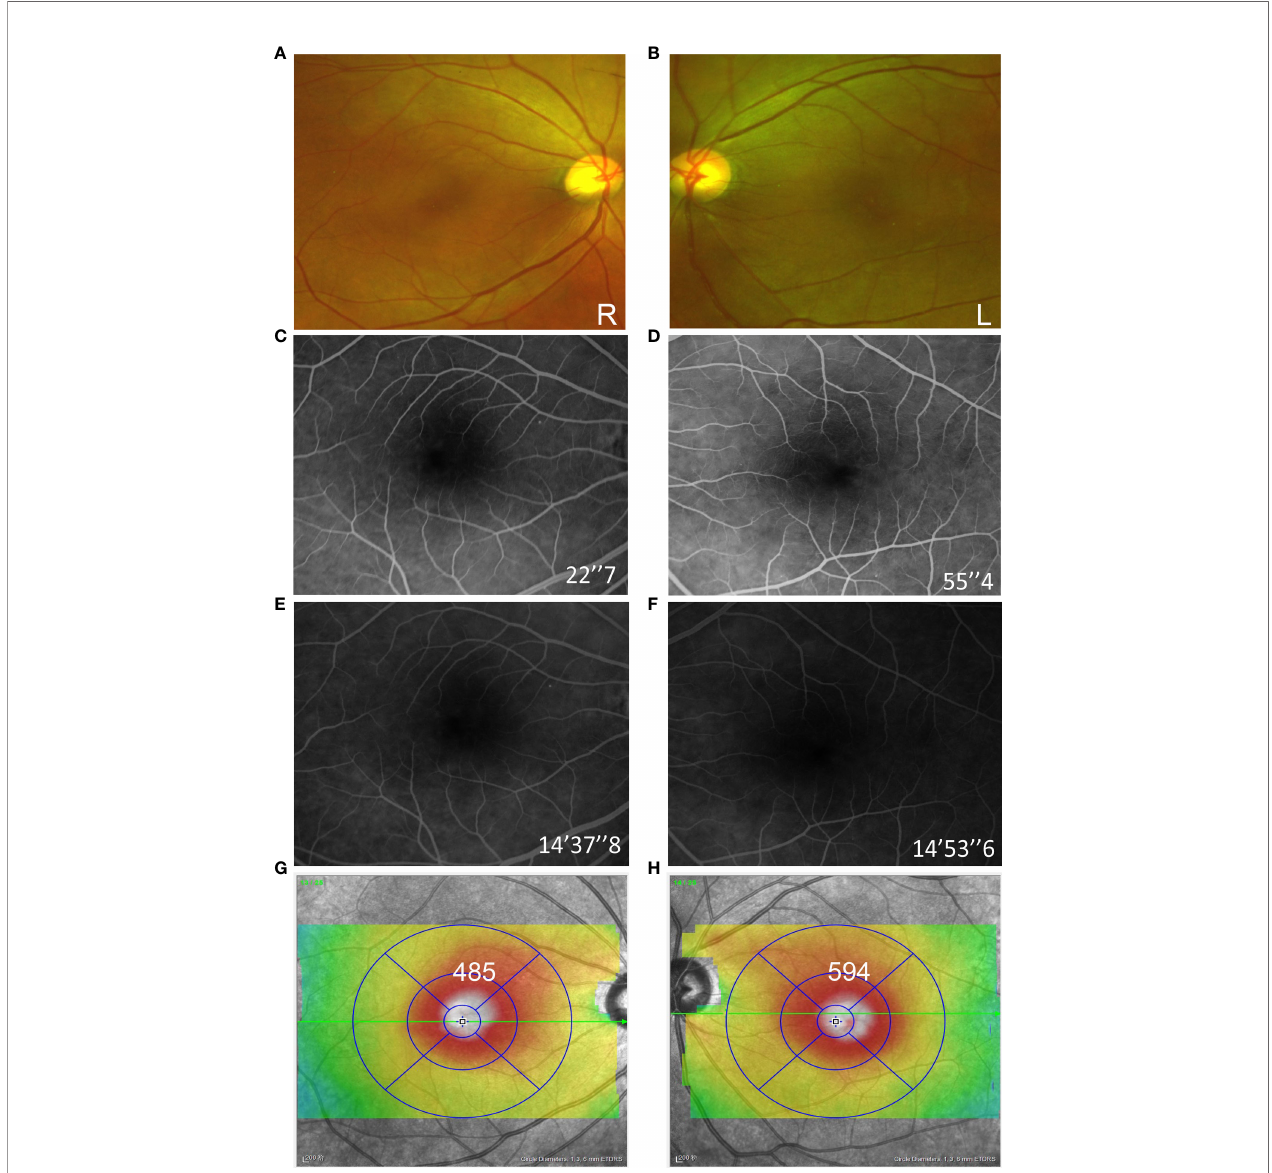
FIGURE 2 | Fundus examination of both eyes at the initial consultation. Ultra-wide fi eld fundus image revealed macular edema in both eyes (A, B) . The fl uorescein angiograms did not reveal leakage from the parafoveal capillaries (C – F) . Optical coherence tomography (OCT) B-scans showed the cystoid edema with a foveal thickness of 485 µm on the right and 596 µm on the left (G, H)